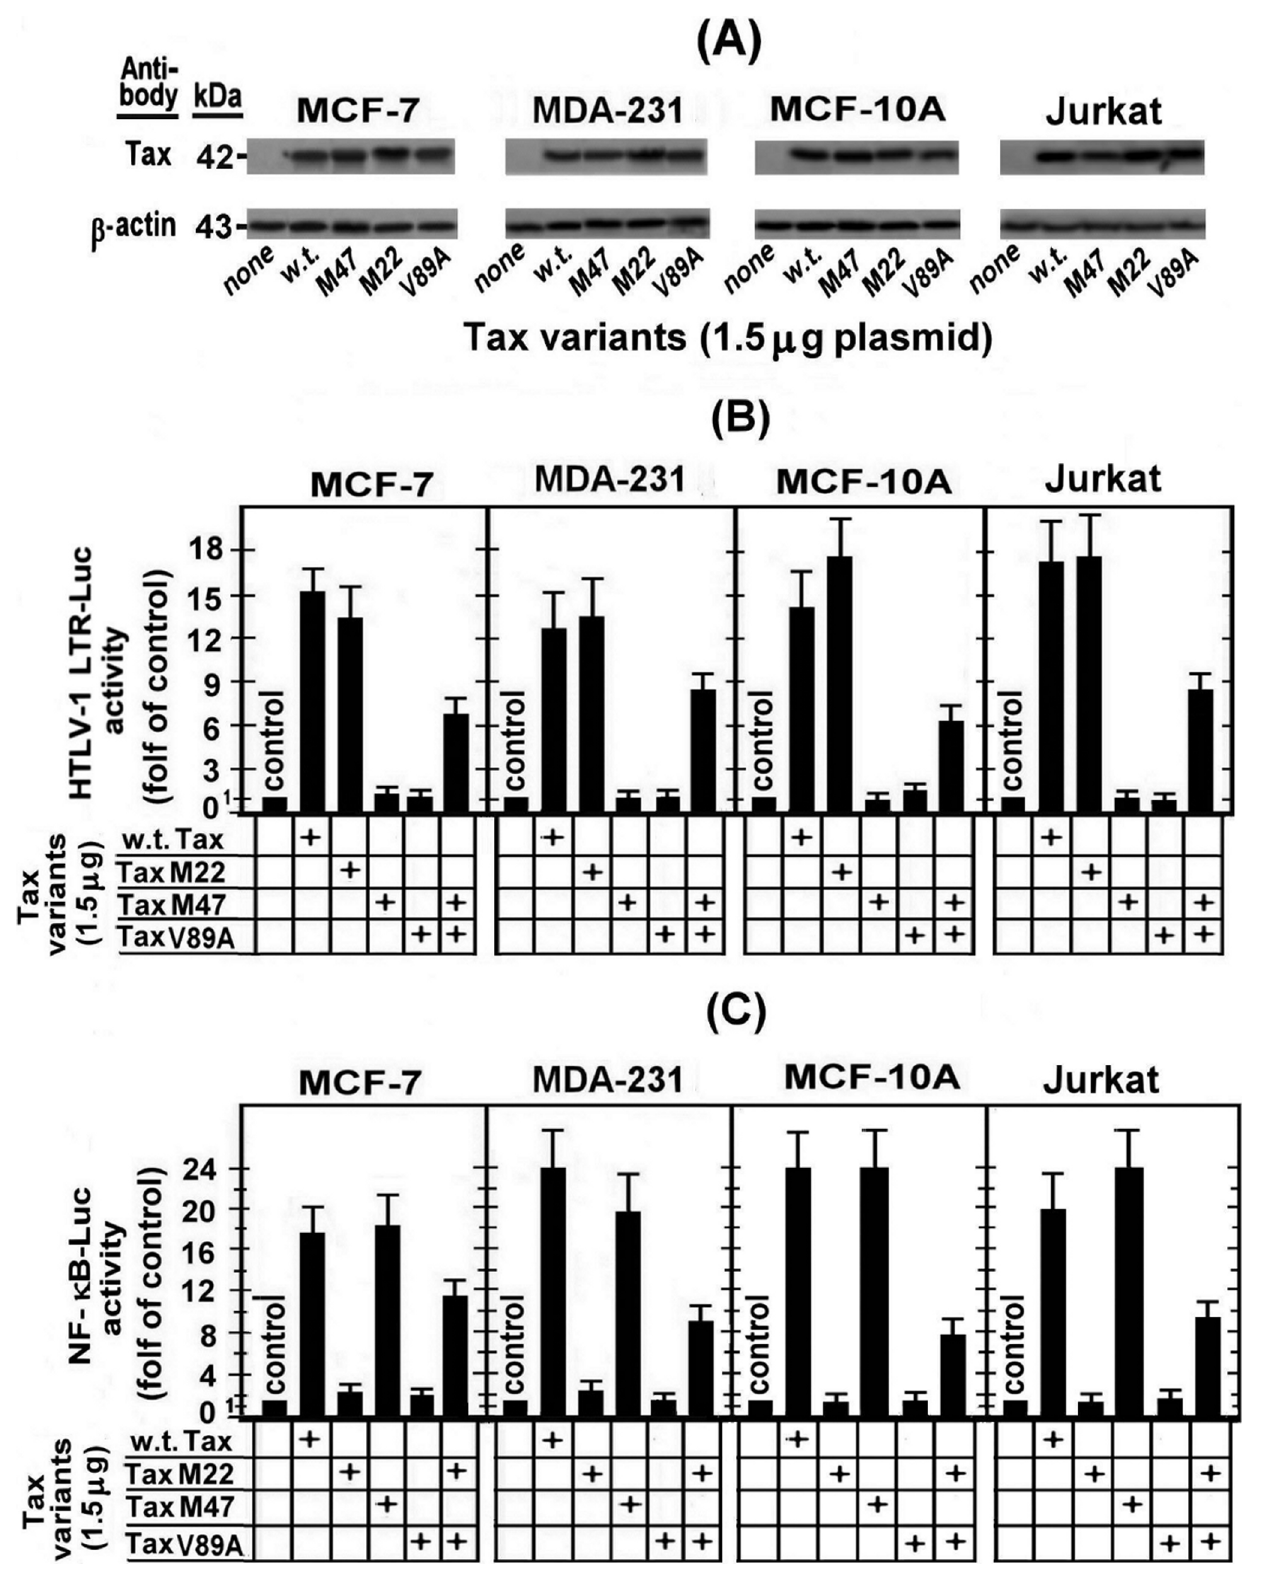
Figure 1. Assessing the expression and functionality of the employed ectopic Tax variants in cancerous and non-cancerous human breast epithelial cell lines. (A) The tested cells were transfected with equal doses (1.5 m g) of the Tax varients plasmids and their Tax protein levels were determined at 24 hr post-transfection by Western blot analysis of the whole cell extracts with Tax monoclonal antibody. Equal sample loading was assessed by re-processing the blot with anti actin antibody. The effect of Tax varients on HTLV-1 LTR-Luc reporter (B) and on the NF- k B-Luc